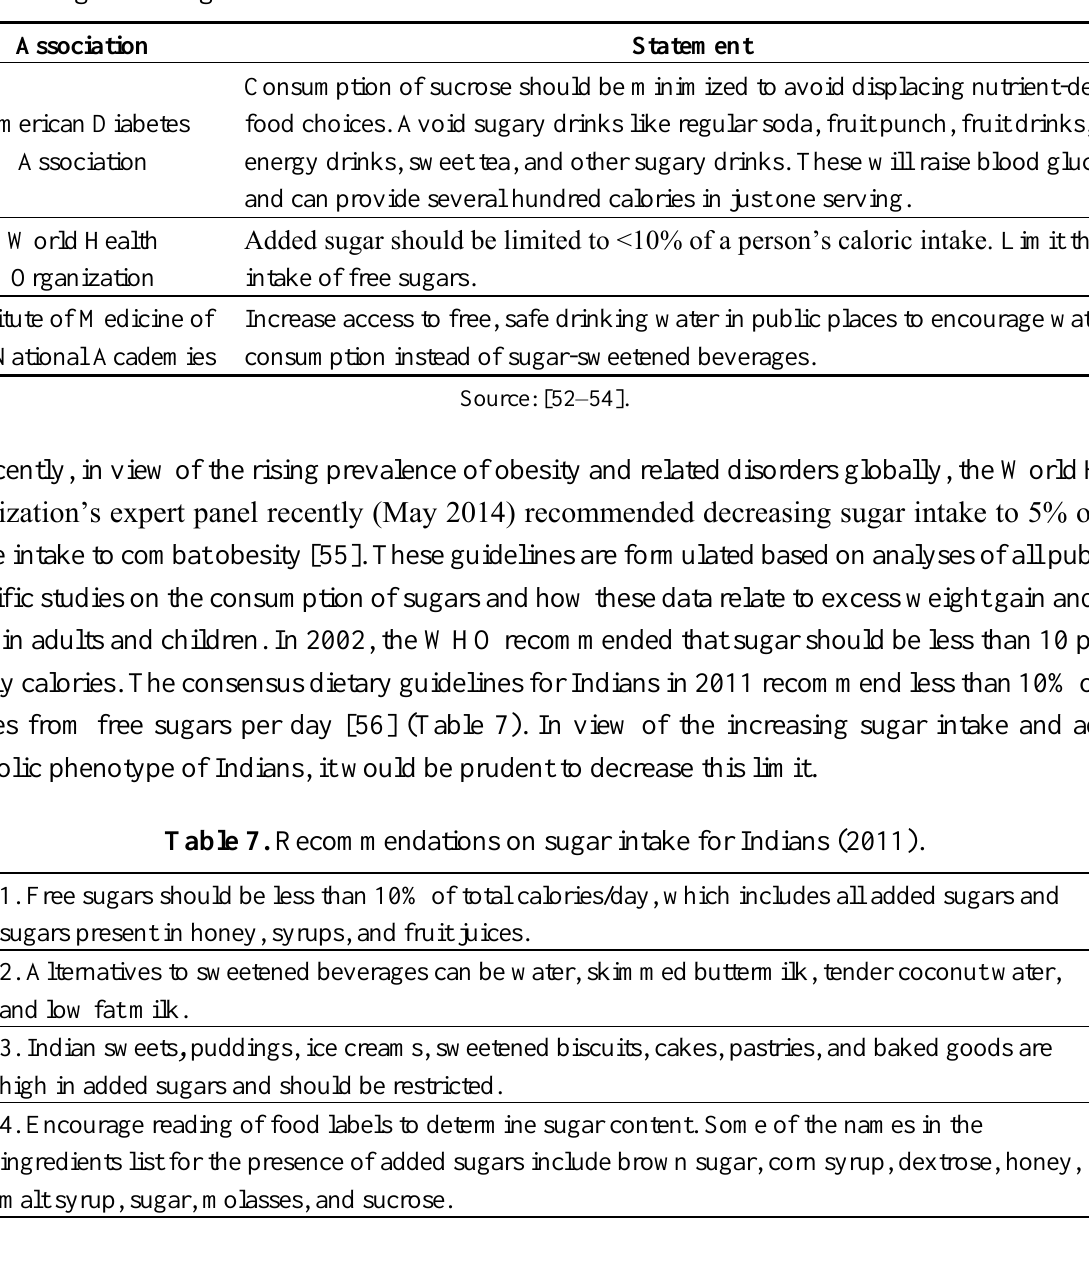
Table 6. Statements from scientific associations supporting a reduction of sugar-sweetened beverages and sugar.